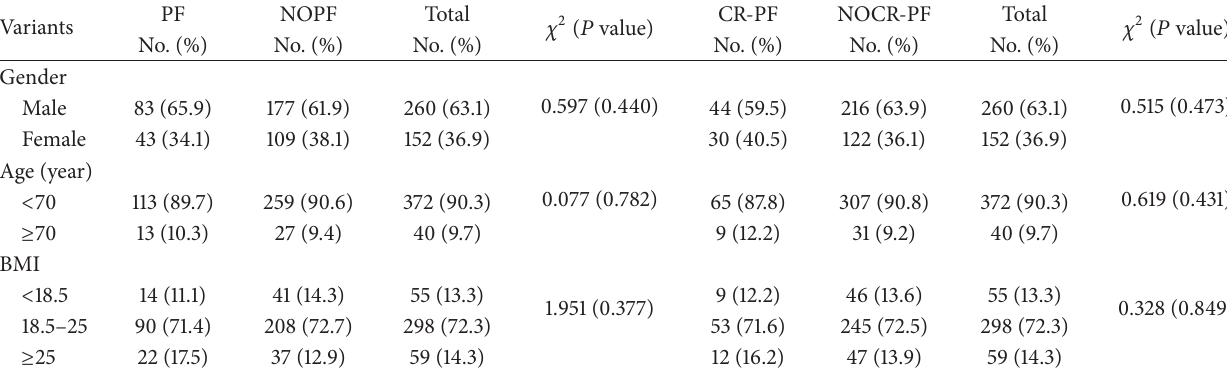
Table 1: Demographic characteristics